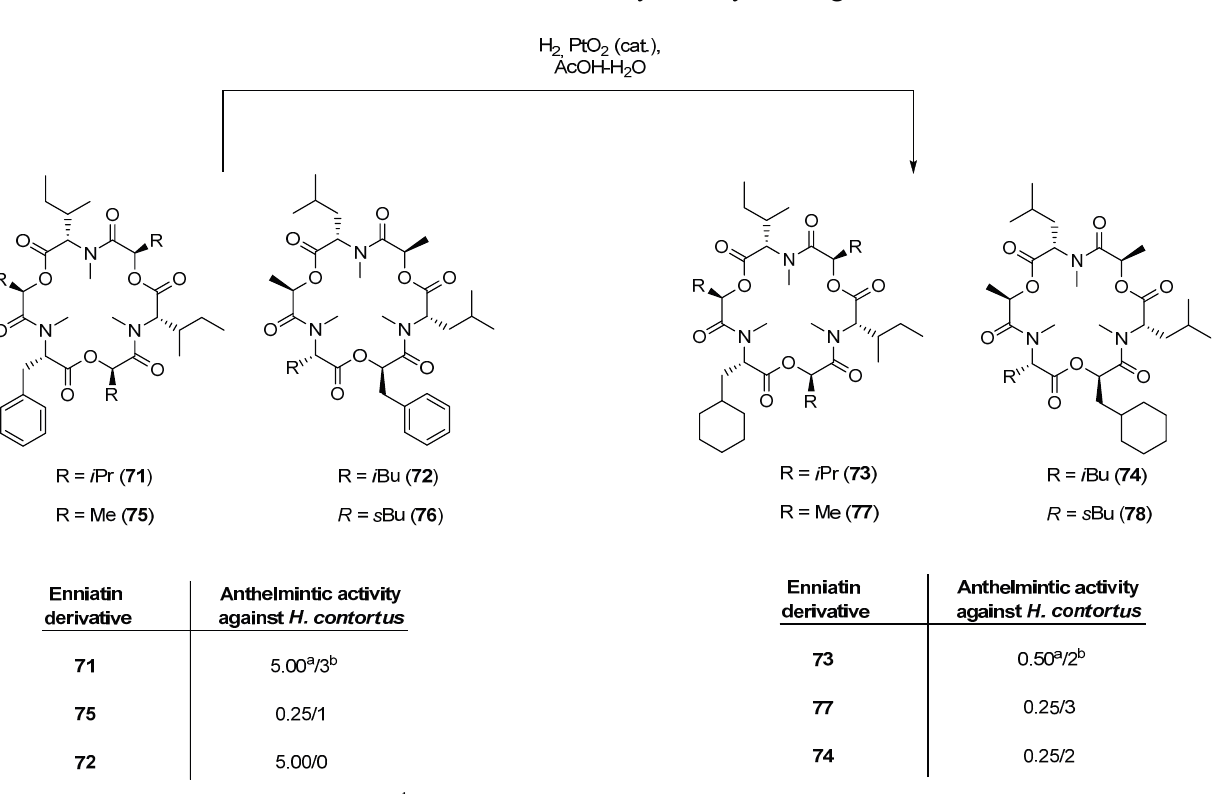
Scheme 7. Structures and activities of cyclohexyl-analogues of